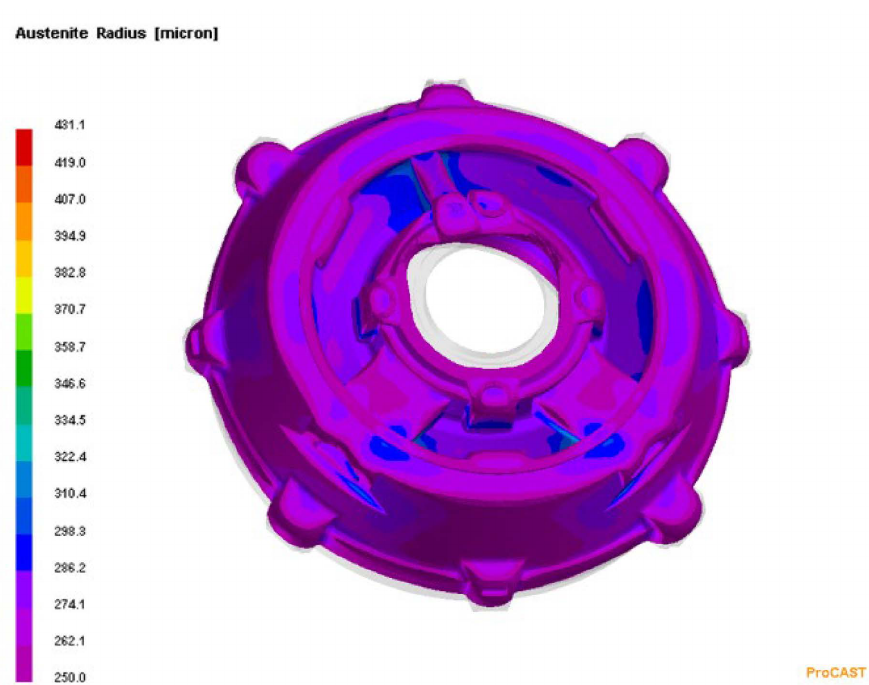
Figure 10. Distribution of primary austenite grains with diameters that were greater than 250 µ m, with a small number of nucleation sites of primary austenite.